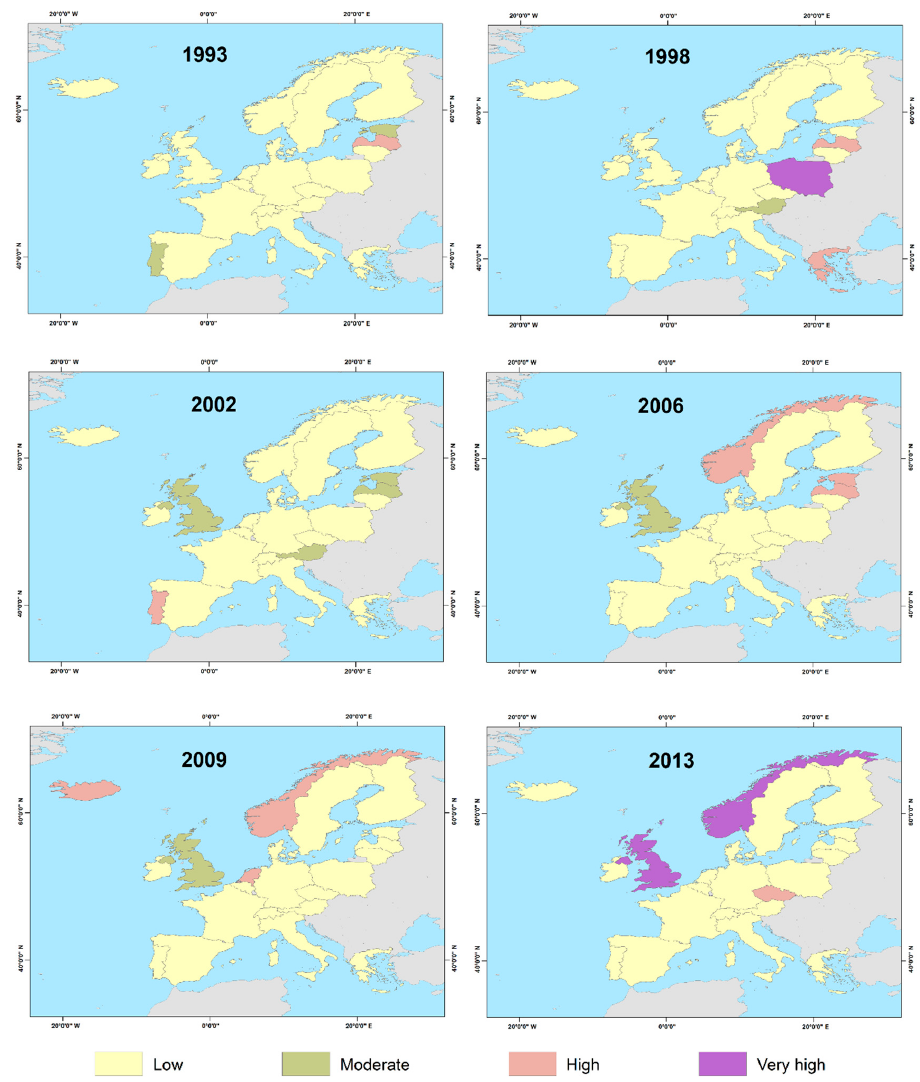
Figure 8. Individual unexpected mortality (parameter κ ) for male gender in 1993, 1998, 2002, 2006, 2009, and 2013.